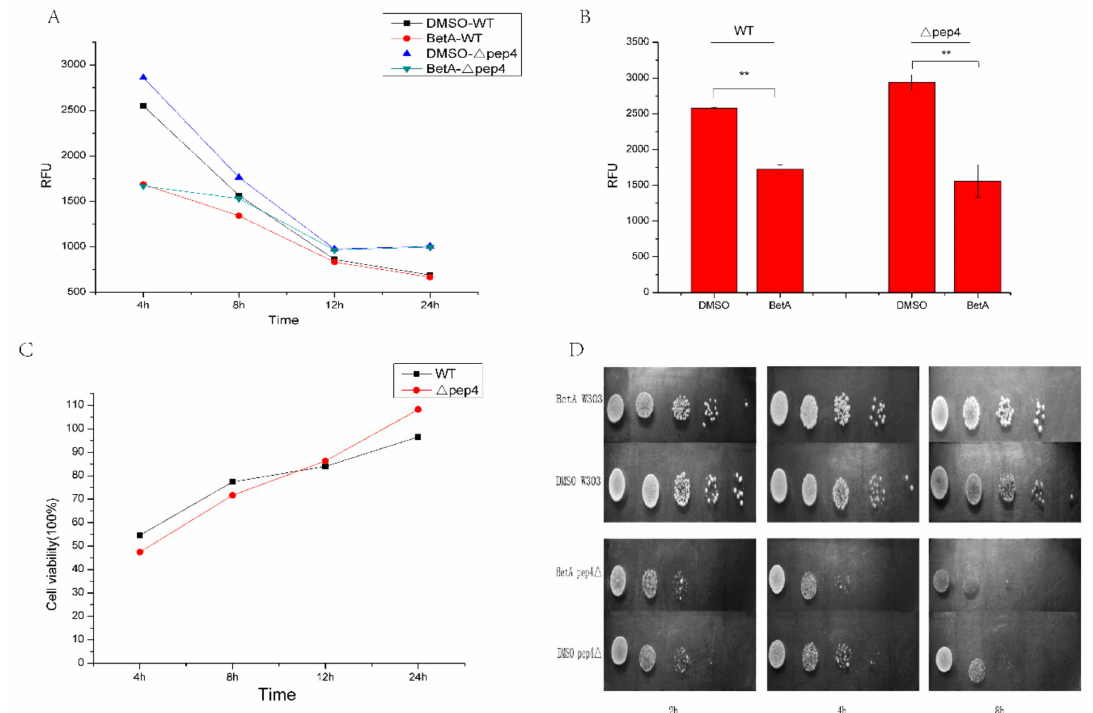
Figure 1. E ff ect of 20 µ g / mL BetA on cell viability and survival of two yeast strains. Data = mean ± SD from three independent experiments, ** p < 0.01. ( A ) Proliferation activity expressed in relative fluorescence units (RFU) after 1 × 10 7 cells were exposed to 20 µ g / mL BetA for di ff erent incubation times. After exposure to 20 µ g / mL BetA for di ff erent times, 10 µ L Cell Blue solutions were added into the medium. Then cells were incubated at 37 ◦ C for 4 h. Measure absorbance using fluorescence with excitation wavelength at 560 nm and emission wavelength at 590 nm using a fluorescence plant reader. ( B ) Proliferation activity expressed in relative fluorescence units (RFU) after exposure to 20 µ g / mL